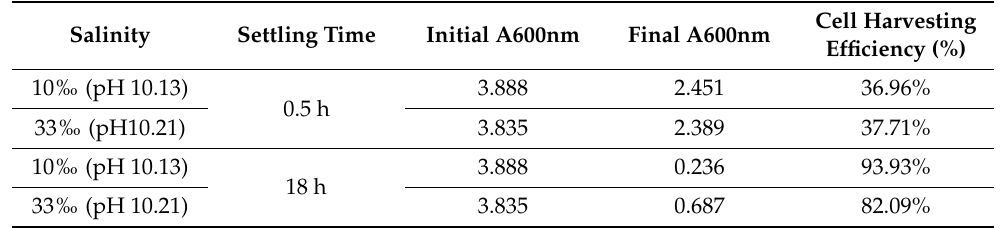
Table 1. Cell harvesting efficiency under different salinity conditions using sedimentation.